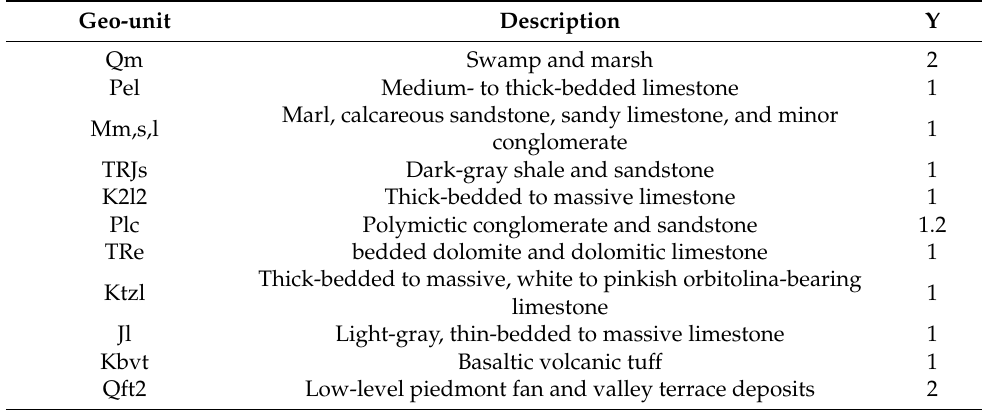
Table 8. Estimation of parameter, Y for the Babolroud